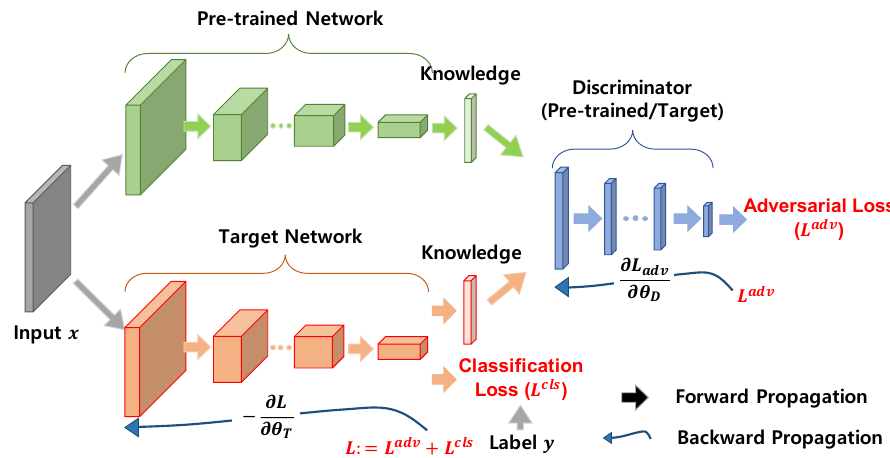
Figure 1. Adversarial-based knowledge transfer framework